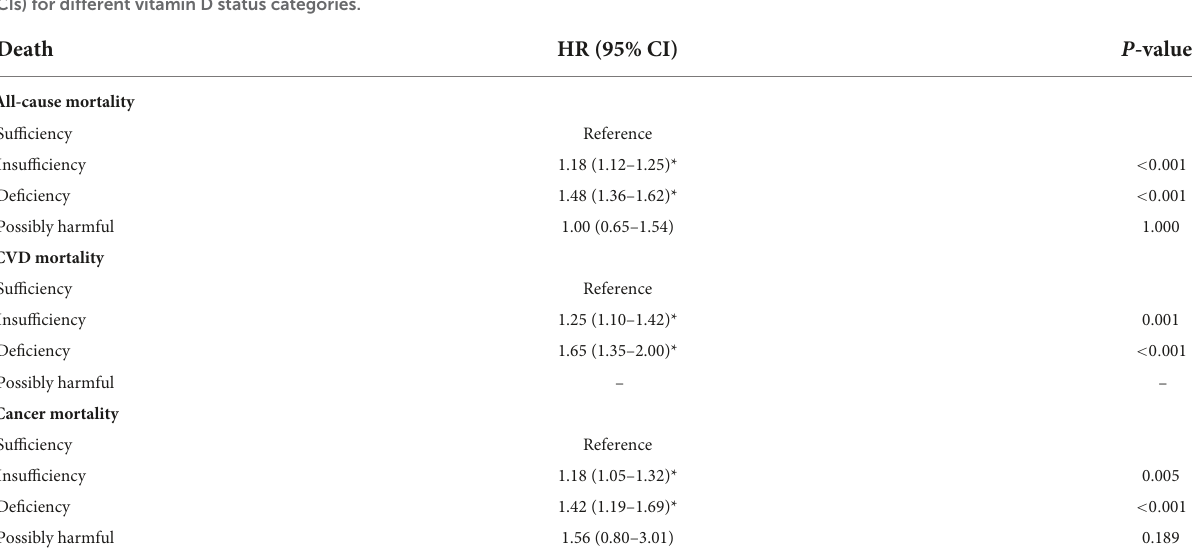
TABLE 3 The associations of serum vitamin D status with all-cause and cause-specific mortality in NHANES III and NHANES 2001–2014: HRs (95% CIs) for different vitamin D status